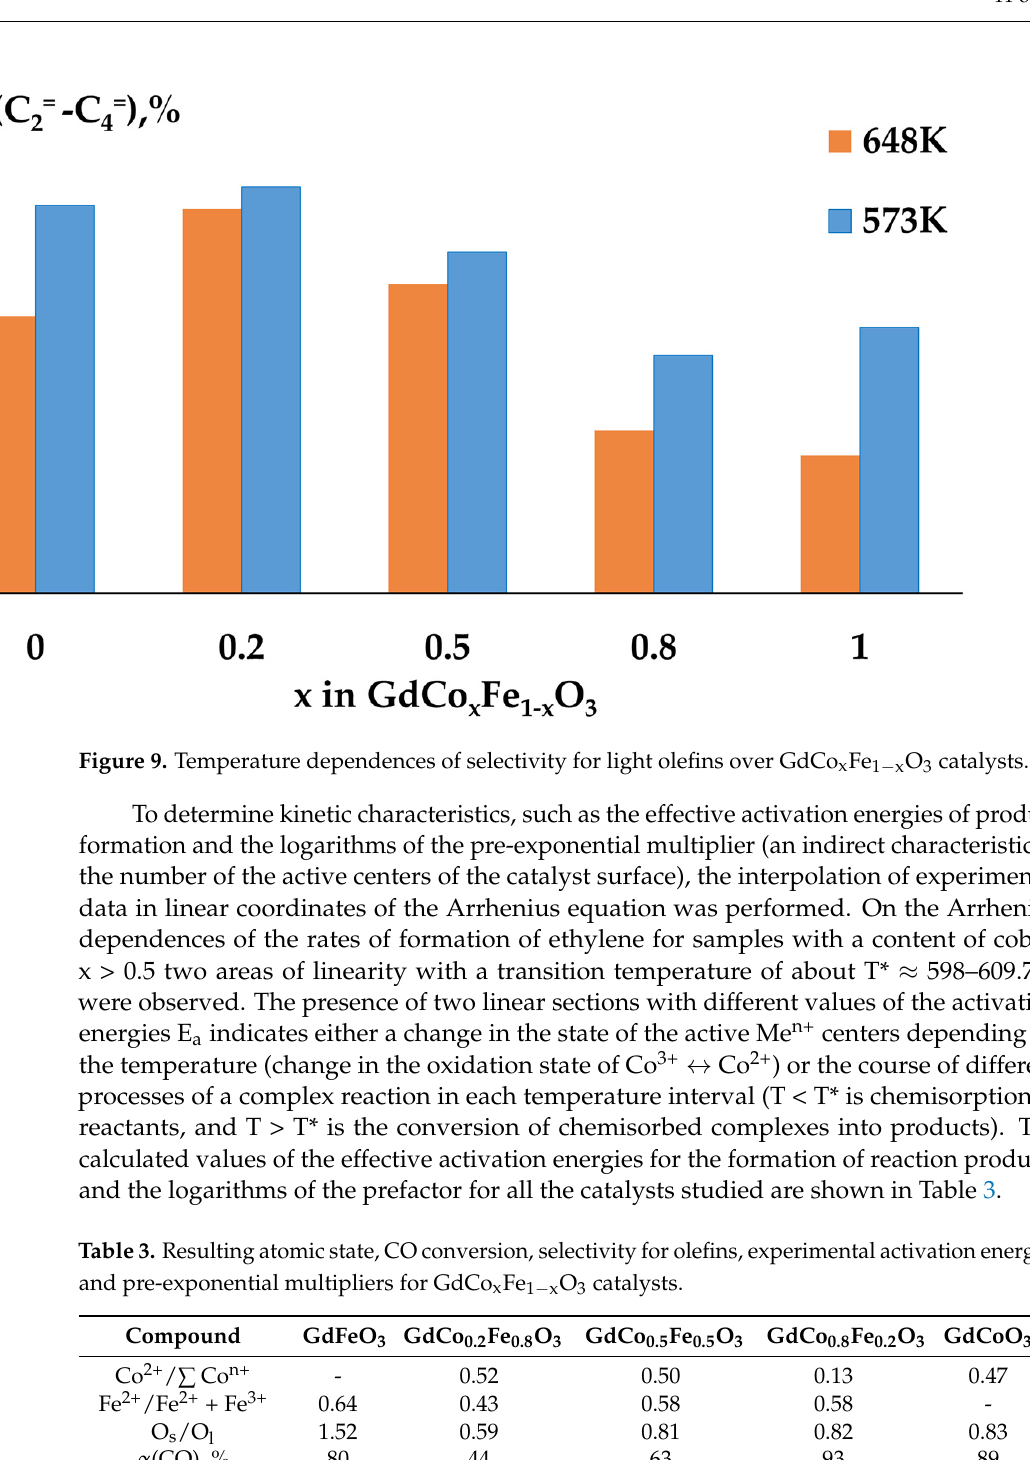
Table 3. Resulting atomic state, CO conversion, selectivity for olefins, experimental activation energies and pre-exponential multipliers for GdCo x Fe 1 − x O 3 catalysts.